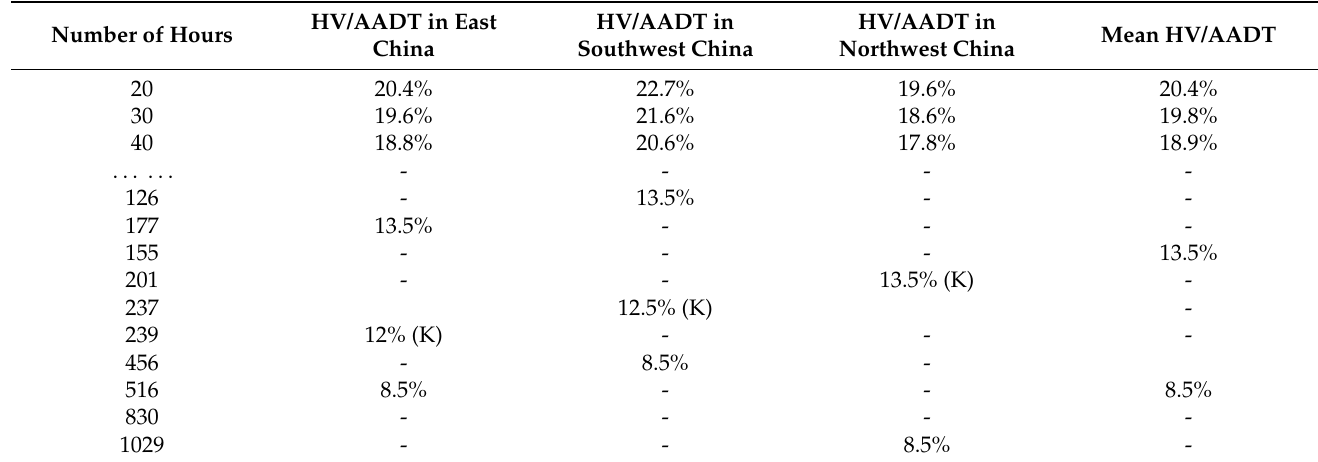
Table 1. Ratio of HV to AADT (typical number of